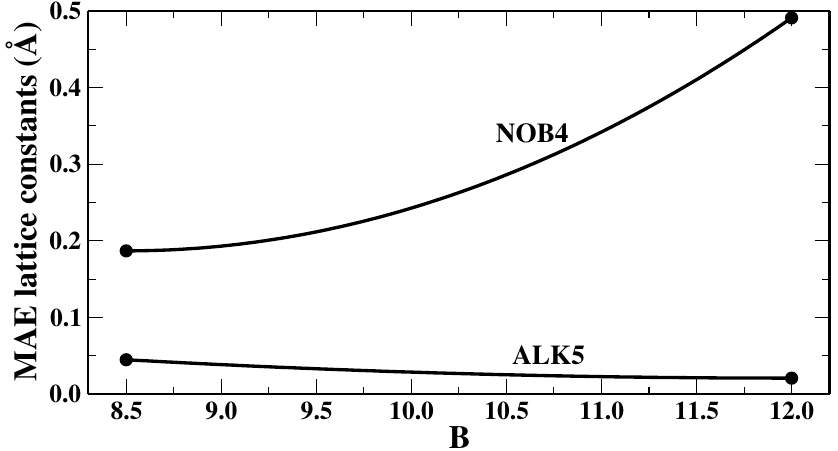
Figure 1. Mean absolute errors, obtained from SG4 + rVV10m as functions of the value of the parameter b in the rVV10m non-local functional (keeping C = 10 − 4 ), for the lattice constants of the NOB4 and ALK5 test